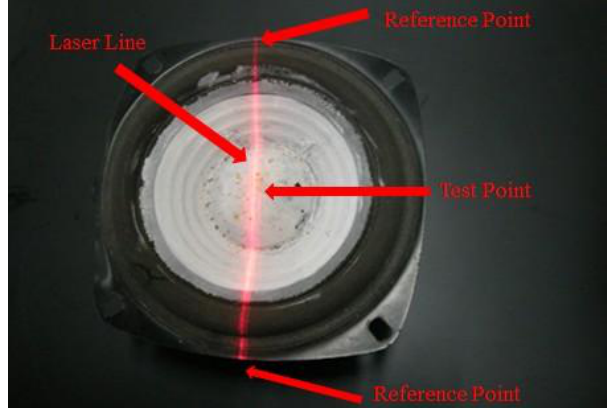
Figure 7. The loudspeaker could be the reference of the frequency calibration of our Parkinson's disease measurement